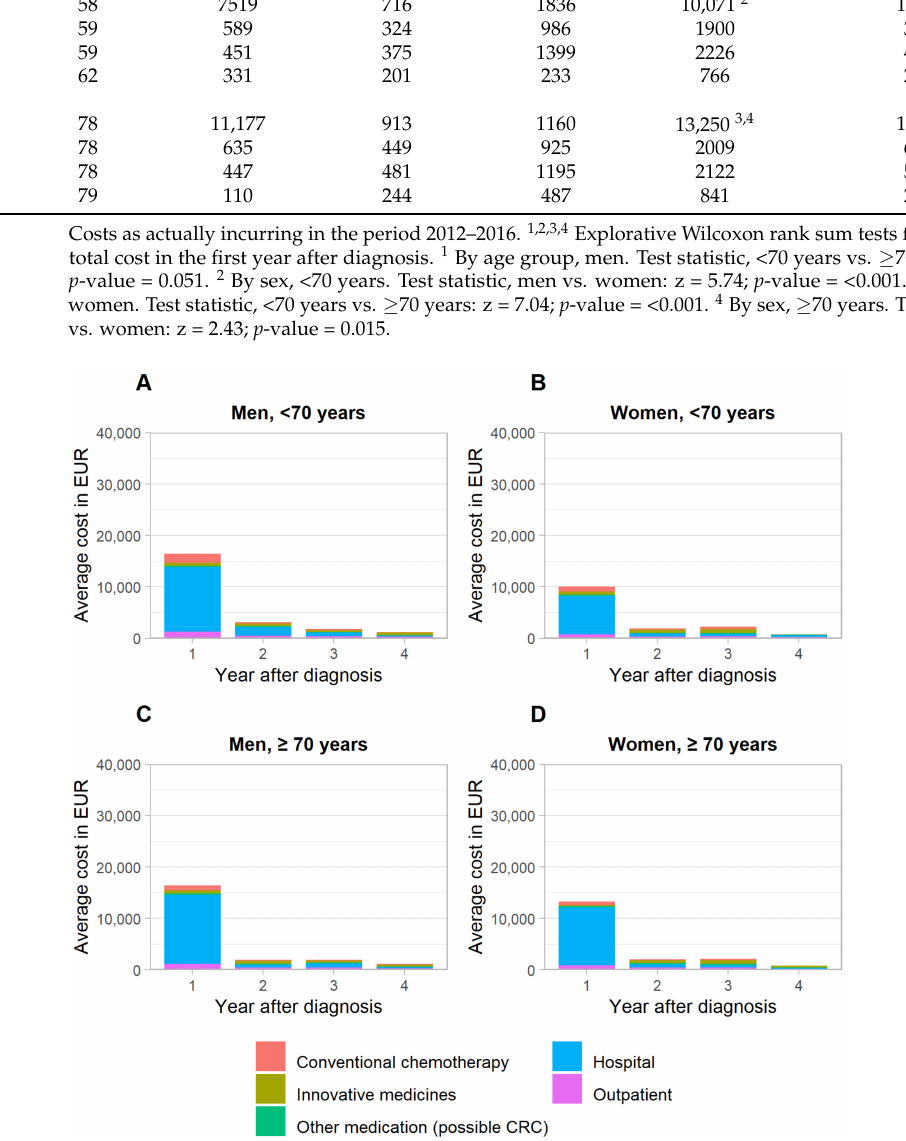
Figure 2. Breakdown of average treatment costs in newly detected colorectal cancer cases, stratified by sex and age. CRC, colorectal cancer. ( A ): Men, <70 years, ( B ): Women, <70 years, ( C ): Men, ≥ 70 years, ( D ): Women, ≥ 70